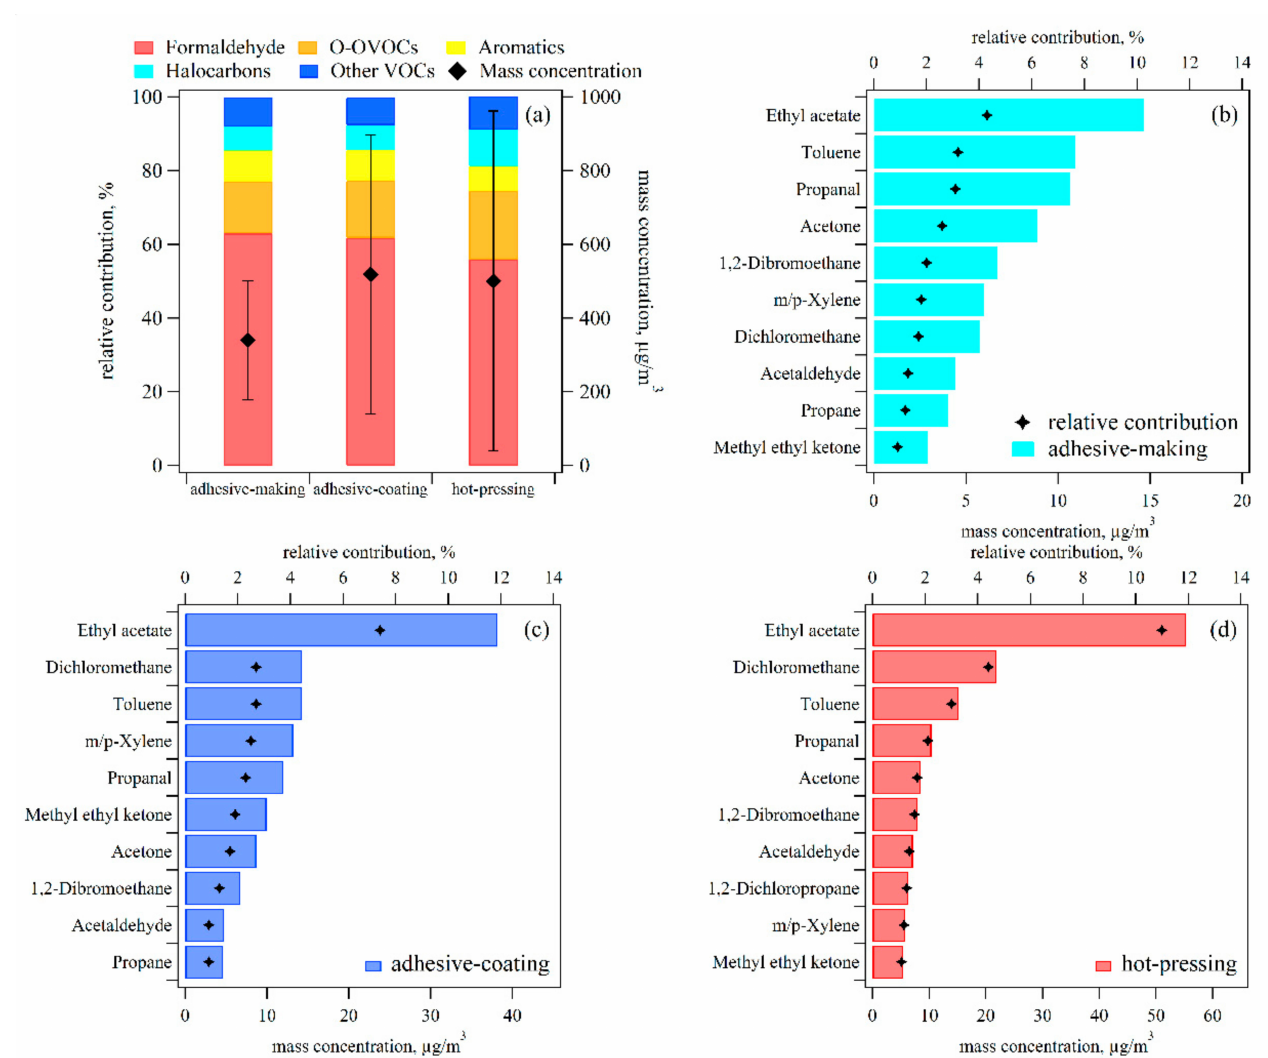
Figure 3. ( a ) Average mass concentrations and chemical composition of VOCs in three processes, and the species with the 10 highest concentrations except for formaldehyde in ( b ) the adhesive-making, ( c ) the adhesive-coating, and ( d ) the hot-pressing processes of the plywood manufacturing industry. The errors bars indicate the standard